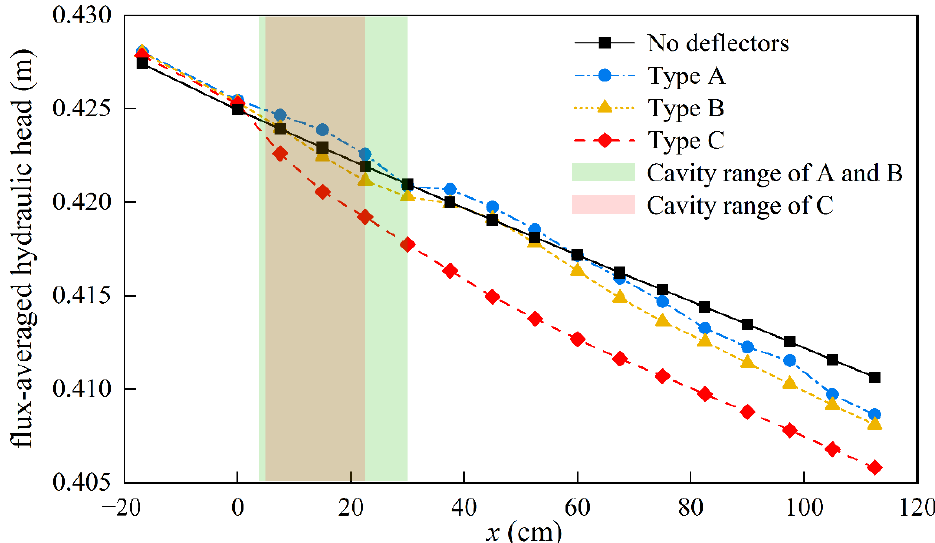
Figure 10. Streamwise development of the flux-averaged hydraulic head (FAHH) along the flume with three different and without deflectors. The brown color indicates regions where the cavity range of C (pink) overlaps those of A and B (green).